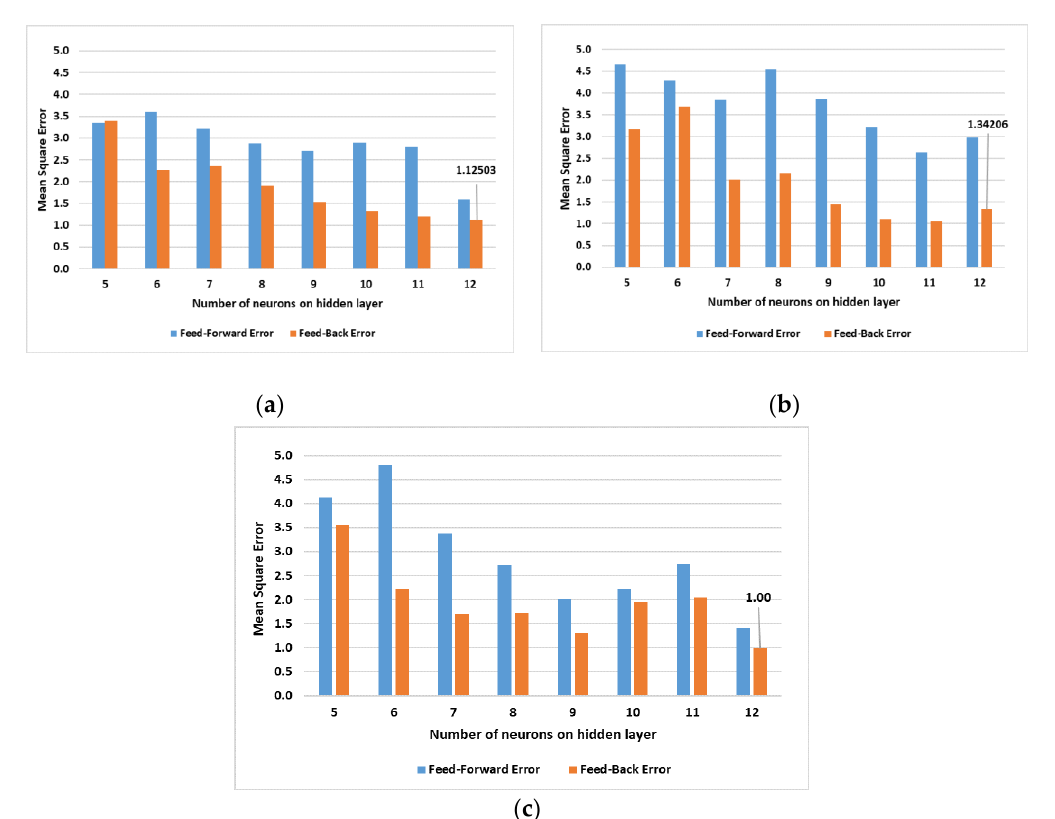
Figure 7. The obtained results by varying the number of neurons on hidden layer for ( a ) 500; ( b ) 1000 and ( c ) 1500 itera- tions.